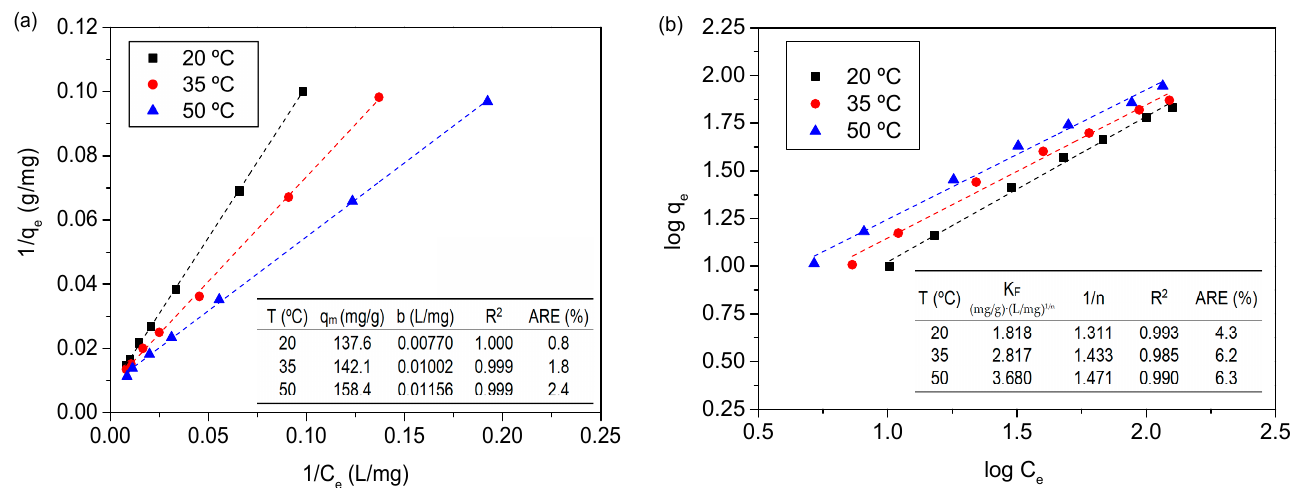
Figure 13. ( a ) Langmuir and ( b ) Freundlich adsorption isotherms for γ -Al 2 O 3 (experimental conditions: adsorbent dosages from 1.5 to 15 g/L, 4 h contact time).